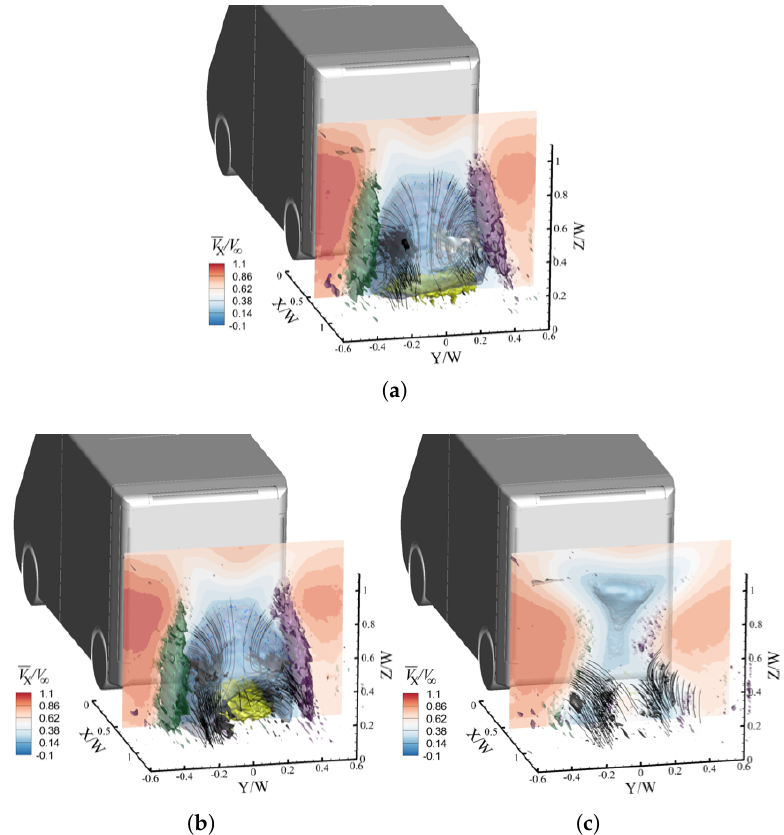
Figure 13. Three-dimensional organization of the wake in the three investigated cases: ( a ) natural; ( b ) best compromise; and ( c ) maximum drag reduction. Contour representation of the mean streamwise component V x / V ∞ at X / W = 0.82. Iso-surfaces of V x / V ∞ = 0.1 (blue), ω Z W / V ∞ = ± 3.2 (green and purple, respectively); ω Y W / V ∞ = − 1.9 (yellow iso-surface); Iso-surface of Q-criterion > 0, color-coded according to values of streamwise vorticity ω X W / V ∞